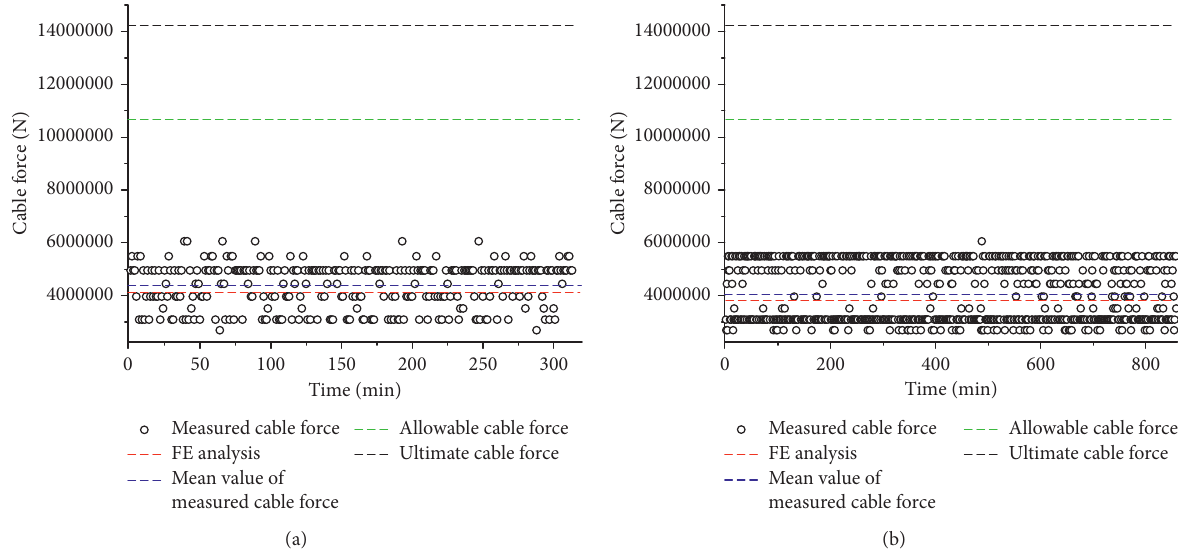
Figure 25: Continuous cable force samples of the 1# stayed cable. (a) Sample measured on 18 September (repair step 1). (b) Sample measured on 25 September (repair step 2).